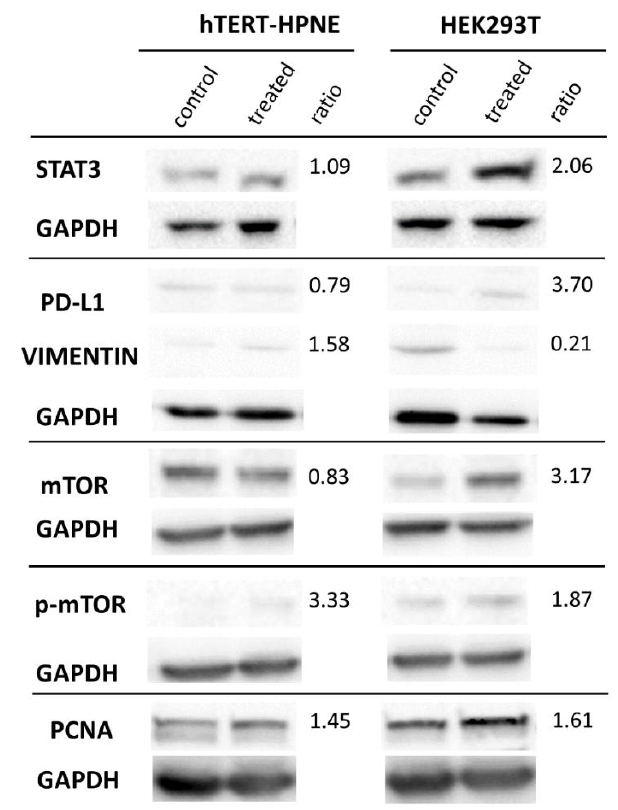
Figure 5. The representative western blot for vimentin, mTOR, p-mTOR, PCNA, PD-L1, and STAT3 each with the corresponding GAPDH protein used for data normalization. The lanes correspond to the following samples: (control) hTERT-HPNE or HEK293 + healthy serum; (treated) hTERT-HPNE or HEK293 + PDAC serum; (ratio) Expression ratio between PDAC and healthy serum treatments in hTERT-HPNE and HEK293T cell lines.